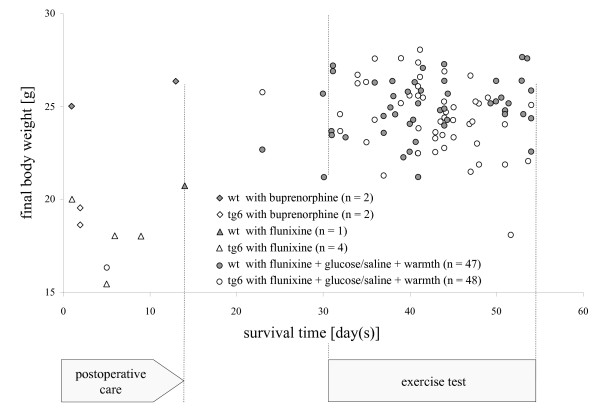
Final body weight in relation to survival time. Each value represents a single animal. Compared to the time point of implantation, the transgenic mice (tg6) without postoperative intensive care (open triangles and diamonds) or permanent bleeding, lost body weight, whereas the 3 wildtype (wt) mice (filled triangles and diamonds) without postoperative intensive care maintained or even increased their body weight, although they did not survive 14 days after implantation. Thus, the progress of the individuals' body weight in the 2-week, critical postoperative period could not be taken as a reliable indicator for assessing the quality of convalescence and for anticipating survival. The mean body weight of 94 mice that received postoperative intensive care and survived for more than 3 weeks was increased from 22 g (standard deviation ± 2) at implantation, to a final weight of 25 g (standard deviation ± 2) on average. The long-term gain of body weight confirmed that the animals were healthy and in good bodily condition for exercising on the treadmill, and that they tolerated the transmitter well.